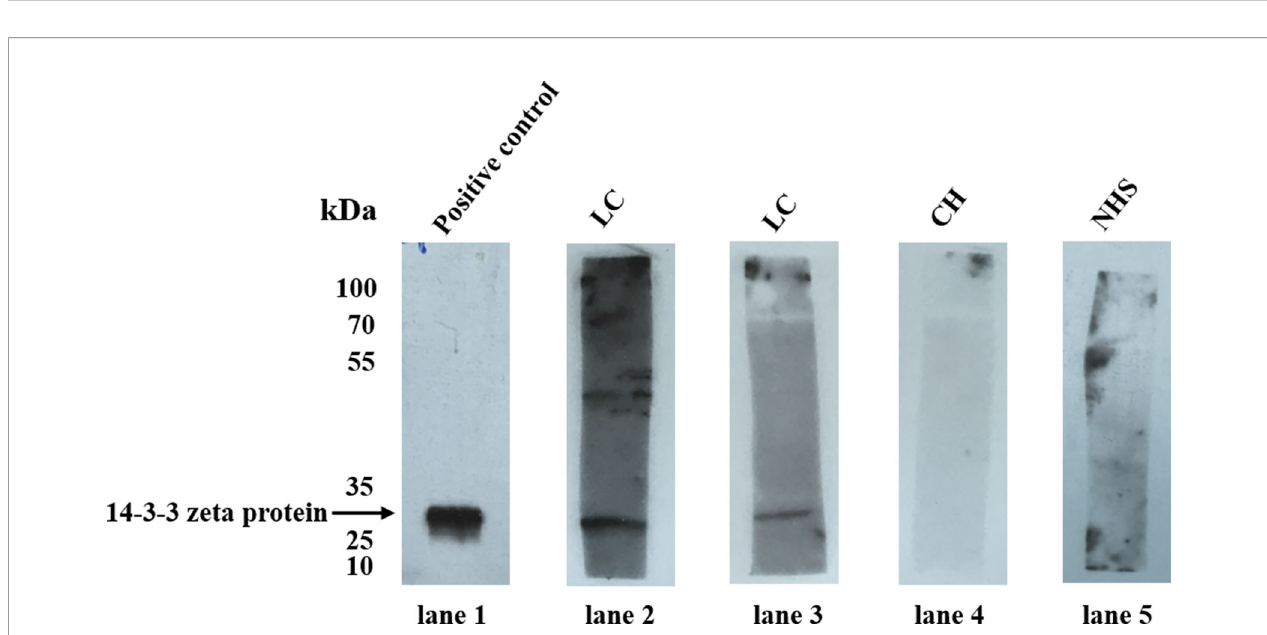
FIGURE 5 | Titer of autoantibody against 14-3-3 zeta in human sera determined by ELISA. The range of antibody titers to 14-3-3 zeta was expressed as that obtained by ELISA. The mean ± 3 SD of normal human serum (NHS) samples is shown in relation to values for all serum samples. The titer of anti-14-3-3 zeta autoantibody in liver cirrhosis (LC) was much higher than that in other types of sera ( p = 0.000).